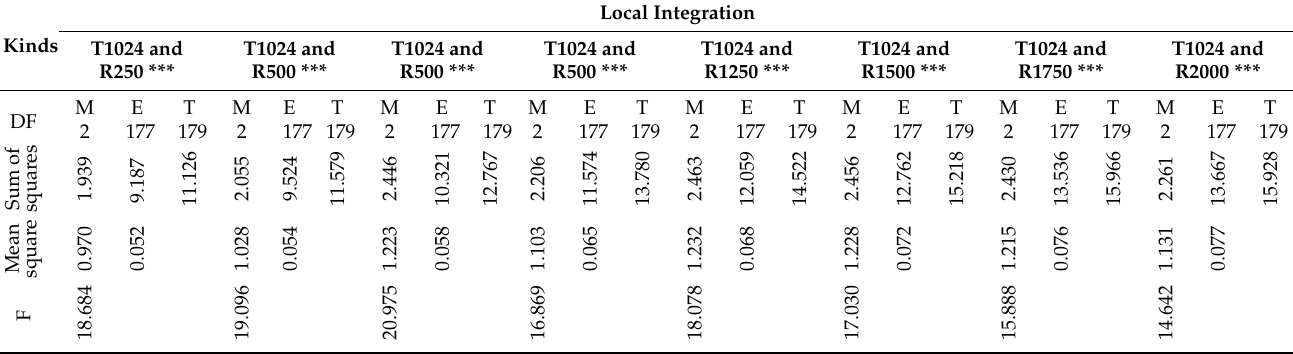
Table 7. Local integration and through angle and limit distance range ANOVA.